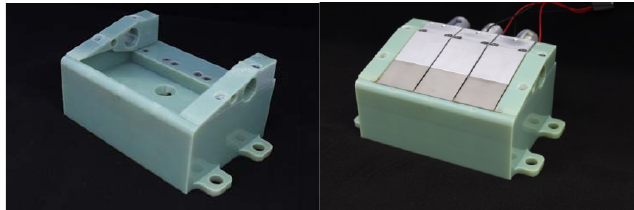
Figure 10. Left: test plenum without lip segments; right: test plenum with the final lip segments.